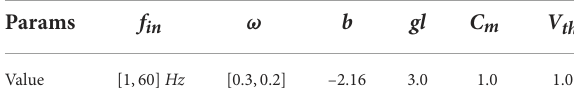
TABLE 3 Parameters setting of simulation